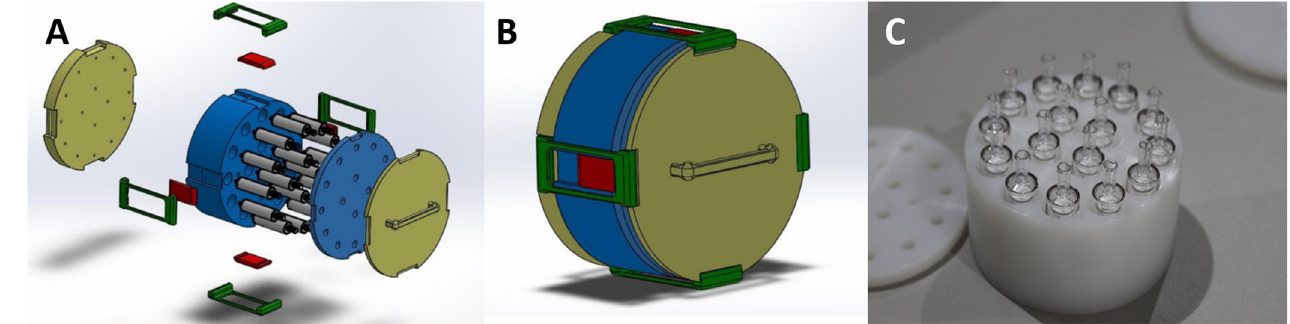
Fig 10. Filter cartridge box. Design of the filter cartridge box open (A) and closed (B); and Sterivex filter cartridge image (C).